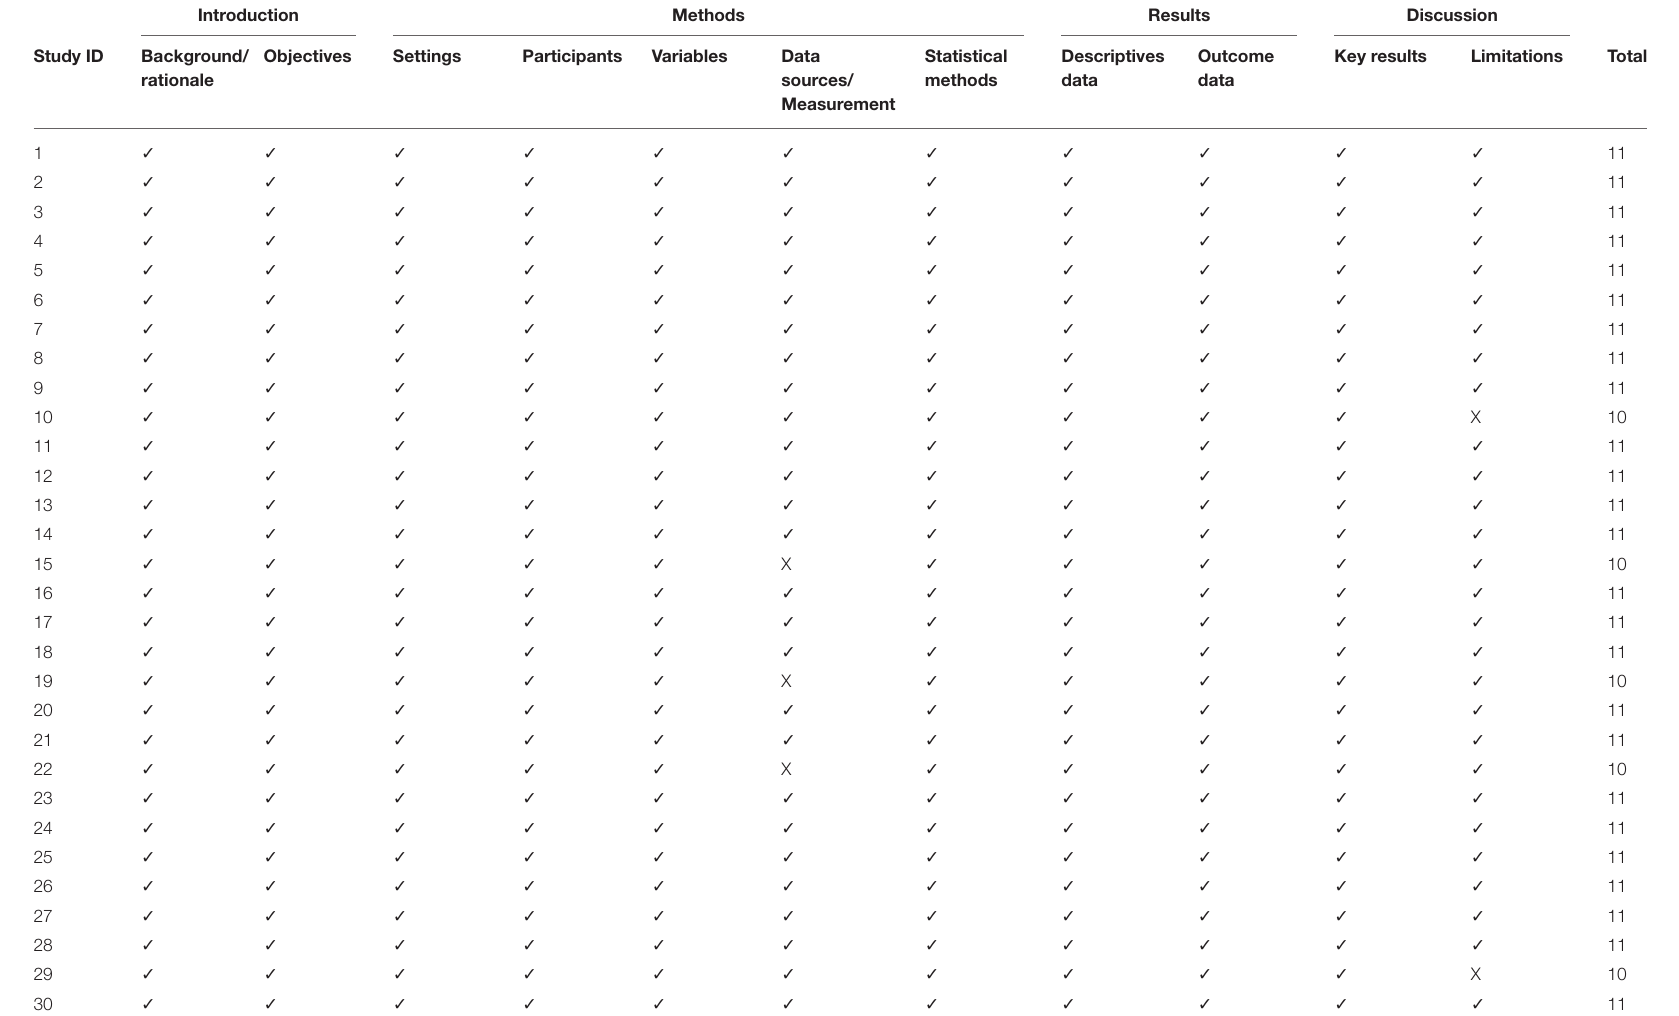
TABLE 3 | Quality assessment of the included